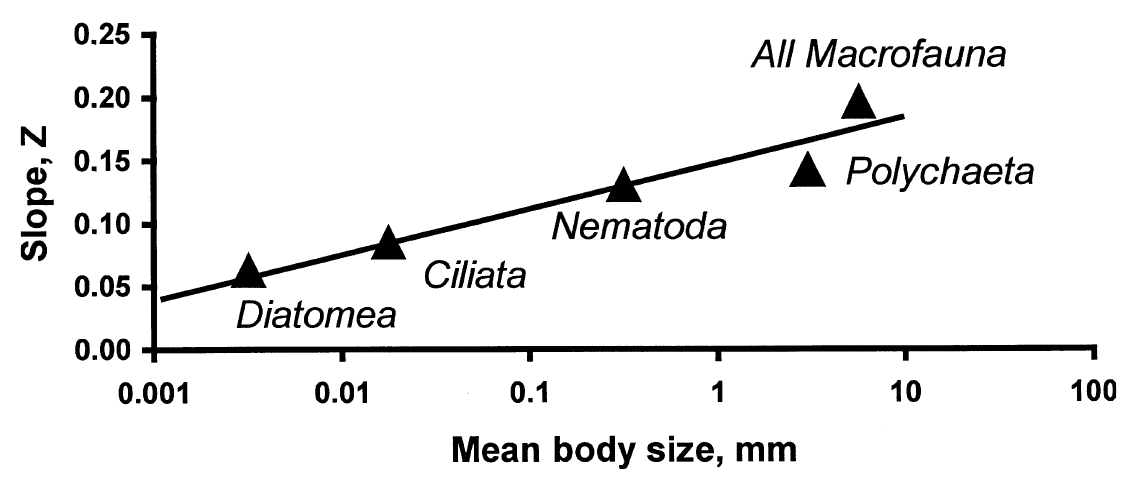
Fig. 5. Species/area curve slopes as function of mean individual body size (R 2 =0.91).